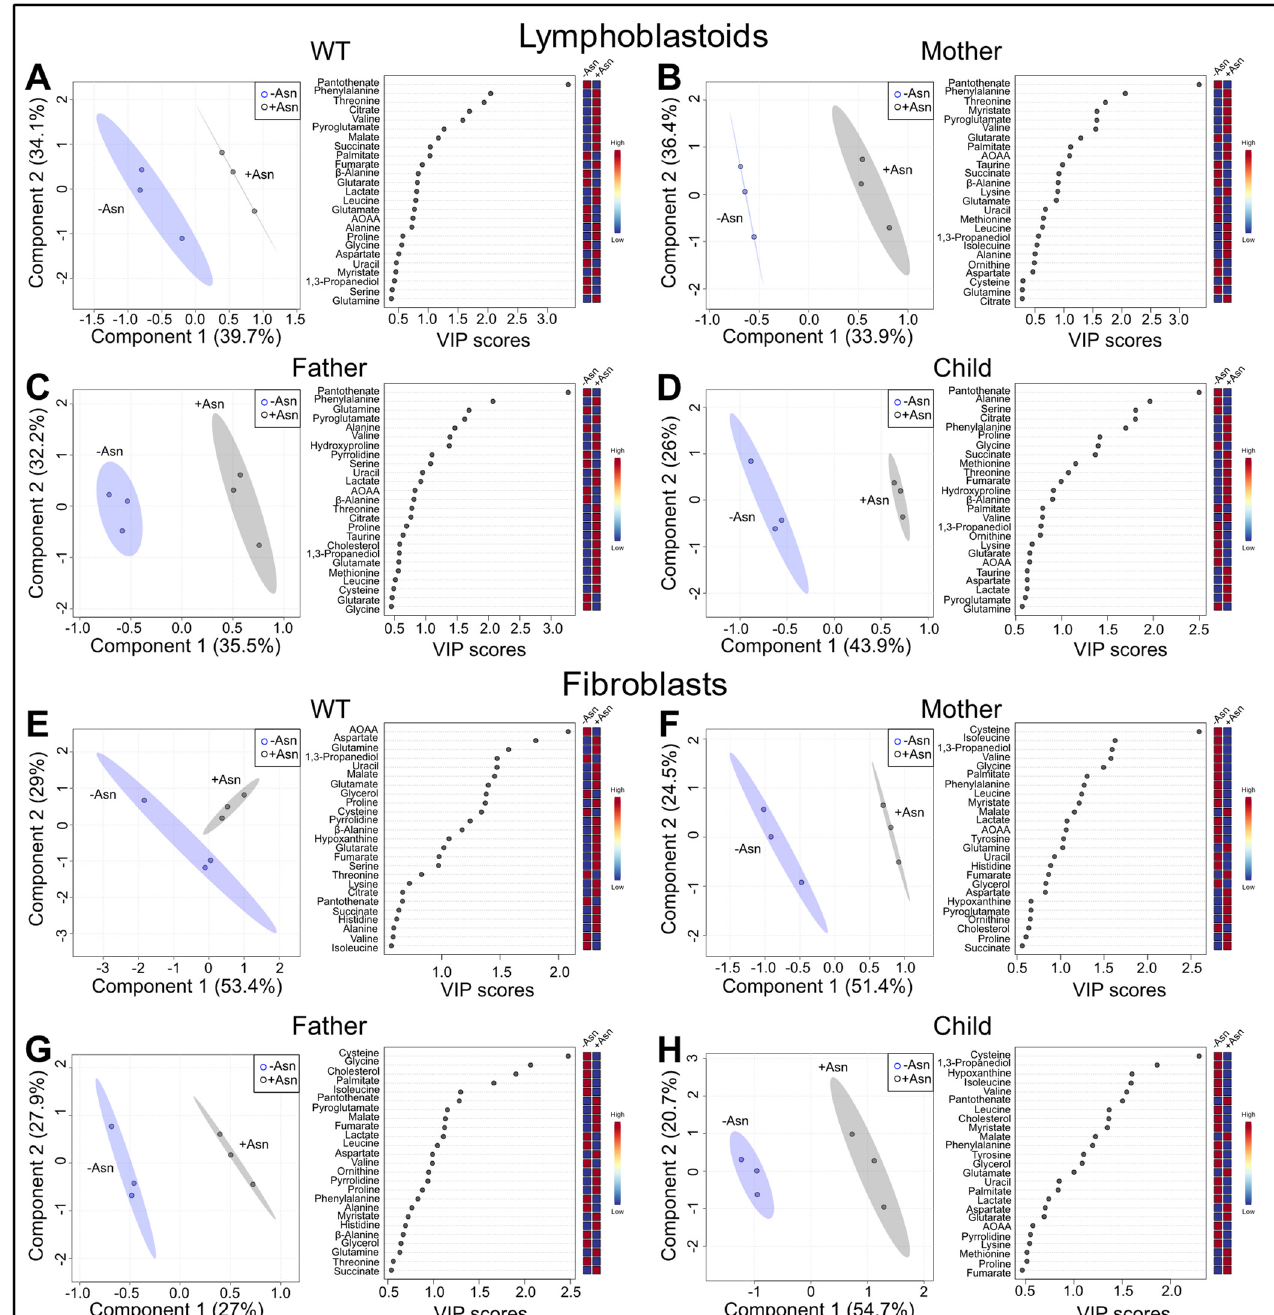
Figure 3. Supervised PLS-DA of LCL and fibroblasts incubated in medium with or without Asn. 2D score plots and VIP score plots are represented for LCL in panels ( A – D ) and fibroblasts in panels ( E – H ). The percentage of variance for components 1 and 2 are represented in the axes of each PLS-DA 2D score plot. For each 2D score plot, the shading indicates the 95% confidence intervals for each group. The VIP score plots of the top 25 metabolites were derived from the PLS-DA analysis and represent the distinct di ff erences between cells incubated in media with or without Asn.